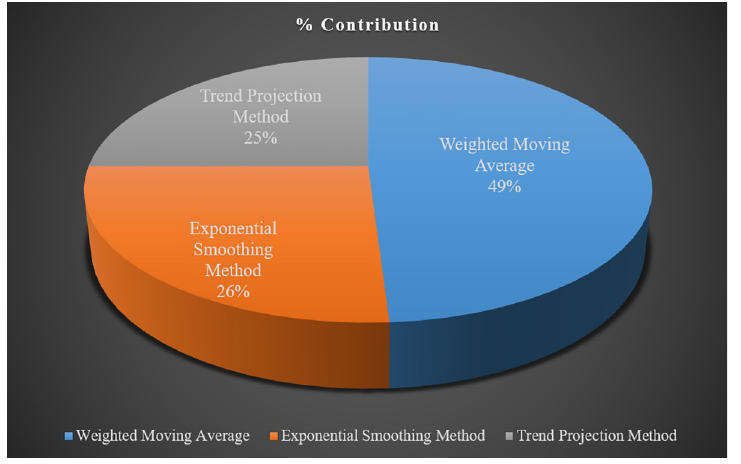
Fig 4. % Contribution of three forecasting methods.